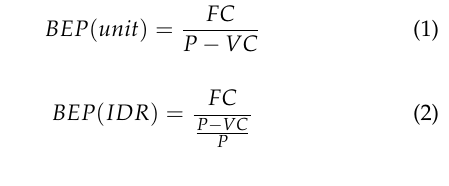
there is a slider to adjust the motor speed. The Motor speed can be set in the range 0-100 RPM. On the right, there is a power button to activate the suction pump. When the suction pump is active, the power button turns green, as well as the display on the smartphone application in Fig. 5 (b). In the smartphone application display, the motor speed slider is on the left, and the temperature graph is in the middle. The results of the temperature readings show in Fig. 6. The data were taken 20 minutes after the production pro- cess started. Based on 20 data, sensor 1 detects the bottom of the pan shows the temperature range is 95-98 °C.